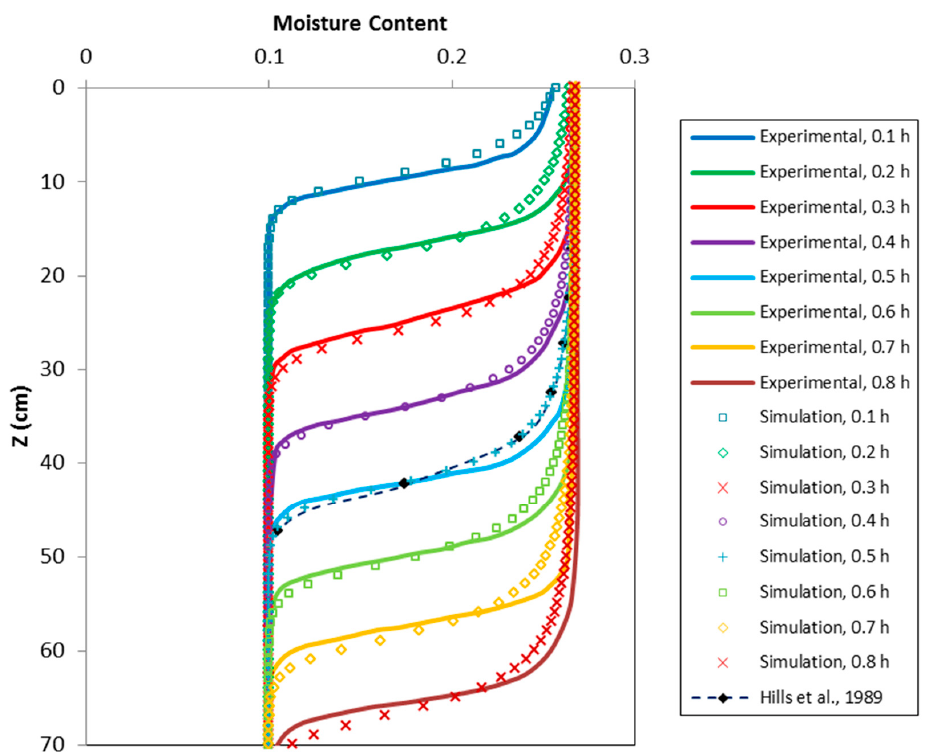
Figure 3. Comparison of model results: The water content profiles (Haverkamp et al. [27] and Hills et al. [28]).